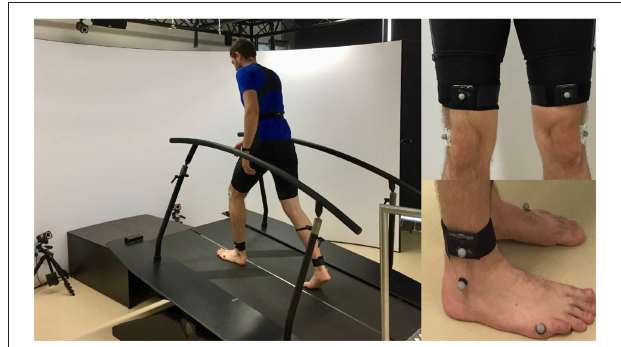
FIGURE 3 | Measurement setup including an instrumented split-belt treadmill and a motion capture system (left) . Inertial measurement unit (IMU) setup for the thigh and the shank (right) . The sensor units were placed in textile straps. The length of the straps was adapted to differences in body composition using velcro. Reflective markers on the sensors were not used for this